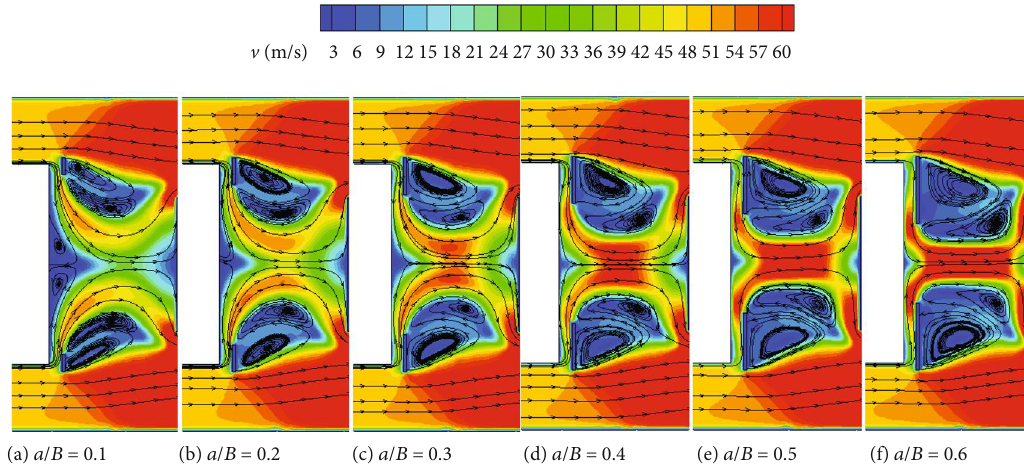
Figure 9: Velocity distribution in the cavity at section Z = 0 mm under di ff erent a / B .